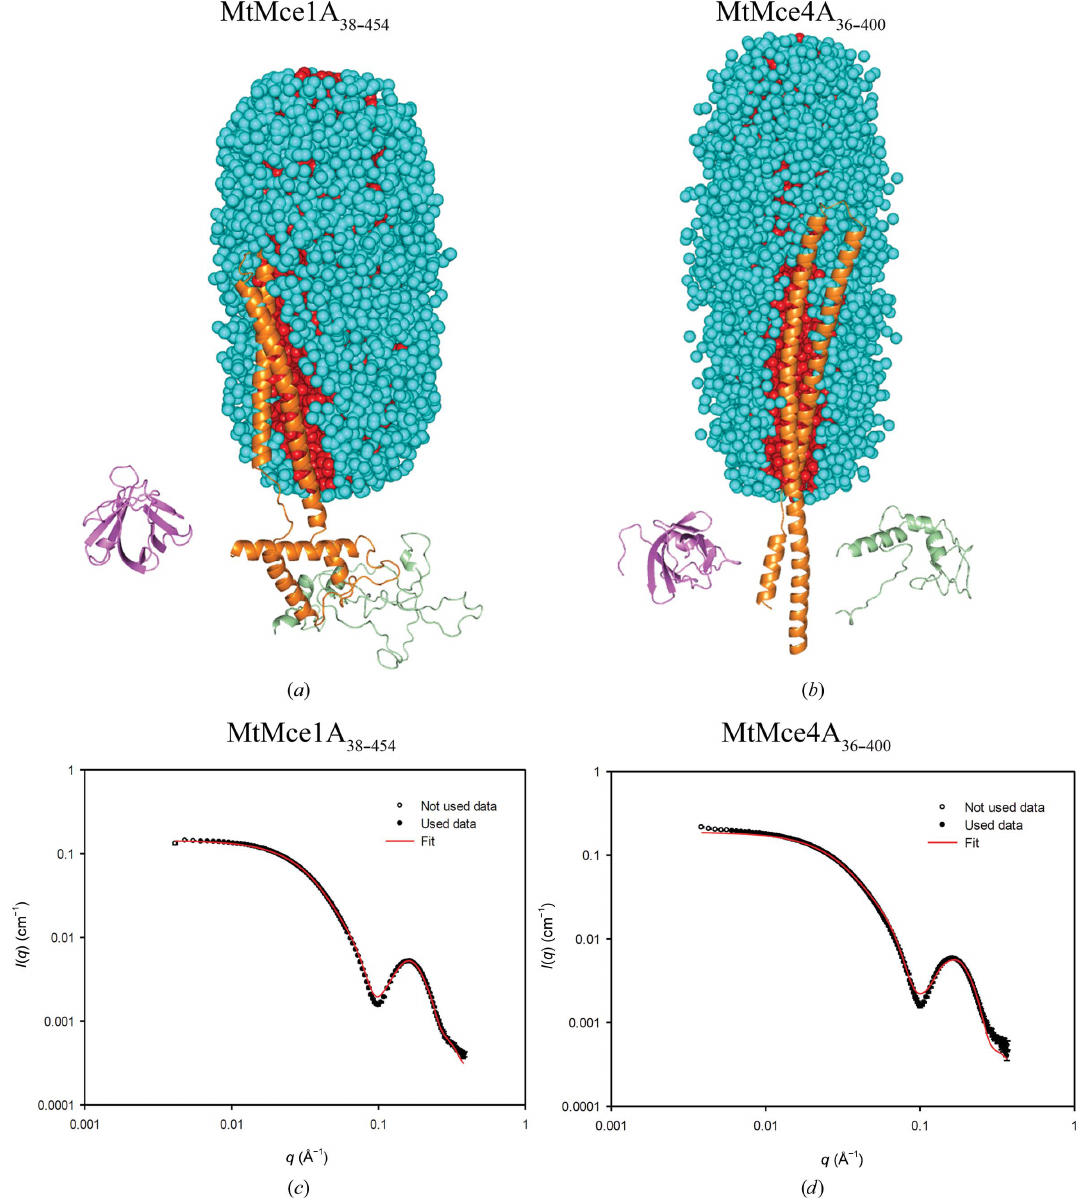
Figure 6 The coiled-coil models of ( a ) MtMce1A 38–454 and ( b ) MtMce4A 36–400 interacting with the core of the DDM micelle. The DDM molecules are represented as spheres and the protein is represented as a cartoon. The model is represented by three domains: the MCE domain, helical domain and tail domain. The MCE domains of MtMce1A 38–454 and MtMce4A 36–400 are shown in magenta. The helical and tail domains are represented in orange and green, respectively, in both models. The DDM core and shell are shown in red and cyan, respectively. The MCE and tail domains are not fully connected to the helical domain, as we used soft restraints between the three domains while fitting the model to the SAXS data to allow some flexibility. ( c , d ) The fits (red line) of the experimental SAXS data (black dots) to the proposed models of ( c ) MtMce1A 38–454 and ( d ) MtMce4A 36–400 are